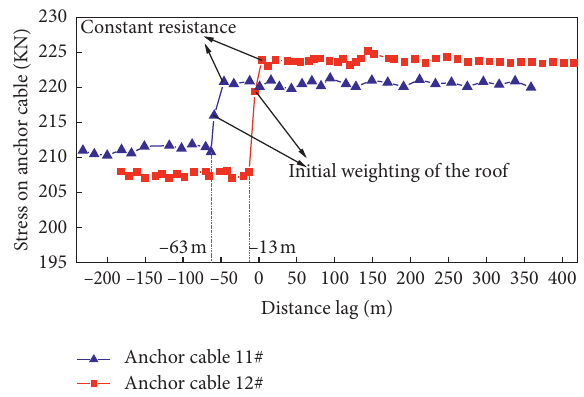
Figure 17: Roadway support elevation. Figure